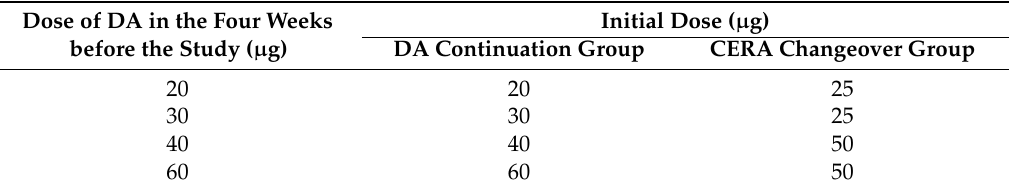
Table 4. Initial dose of erythropoiesis-stimulating agent.